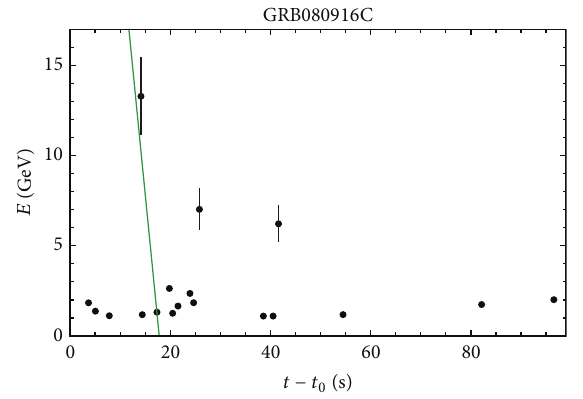
Figure 11: Here shown are the same data points already shown in Figure 10, but now the straight line added on top of the data point has exactly the slope we derived in Section 3 (Figure 4), without any rescaling.